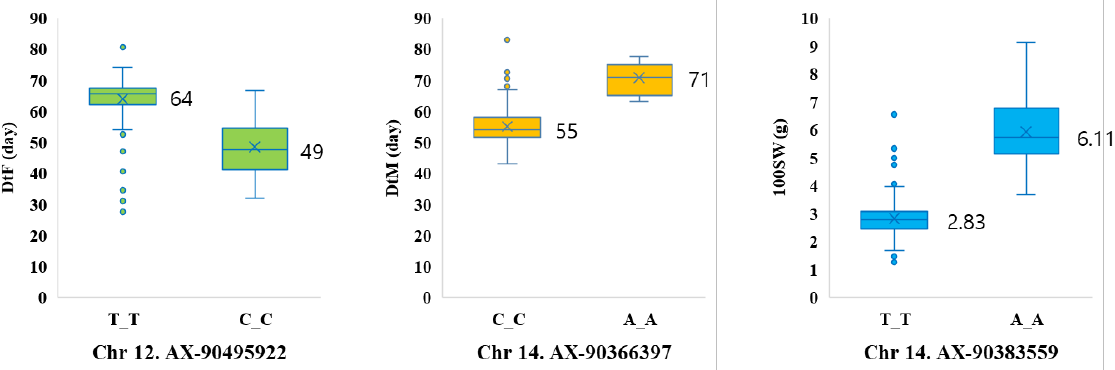
Figure 6. Phenotypic differences between lines carrying different alleles for SNPs associated with DtF, DtM, and the 100SW. DtF, days to flowering; DtM, days to maturity; 100SW, 100-seed weight.